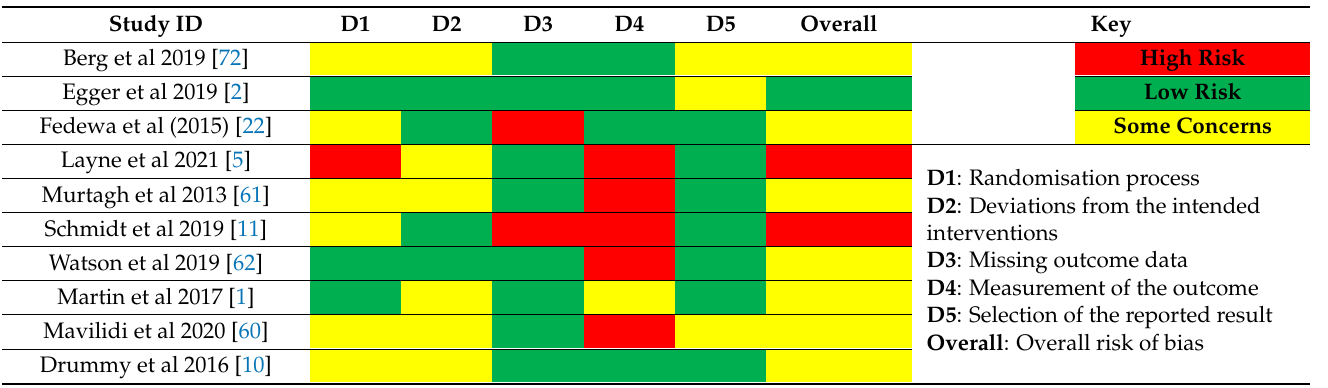
Table 3. Risk of Bias in the Selected Studies.